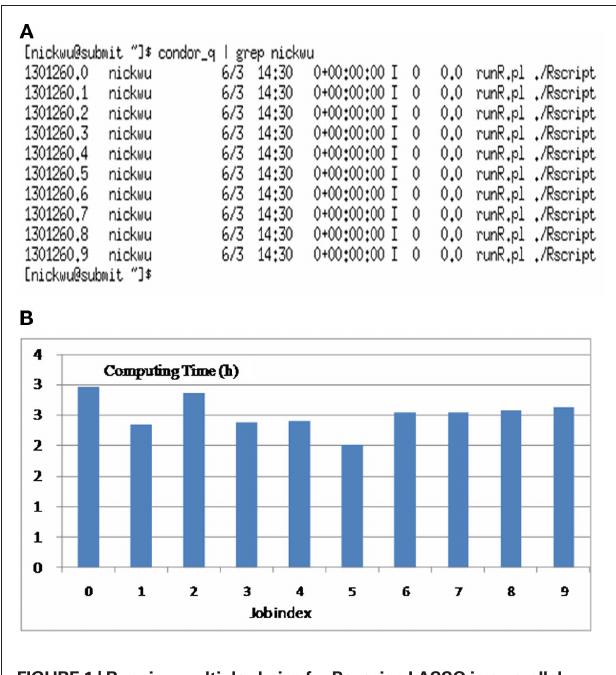
FiGure 1 | running multiple chains for Bayesian LASSO in a parallel setting: (A) list of processes showing 10 running jobs; (B) computing time for the 10 jobs (numbers on the x -axis indexes jobs and the numbers on the y -axis represents computing time in